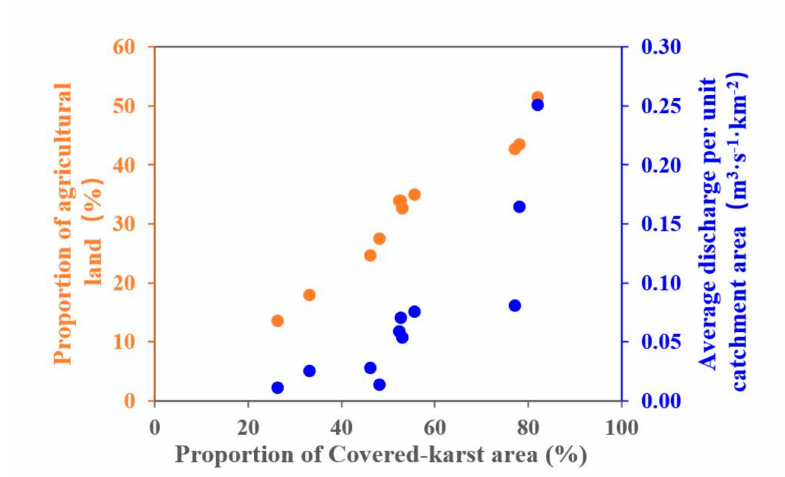
Figure 10. Scatter plots of the relation between the proportion of covered-karst and agricultural land, the average discharge per unit